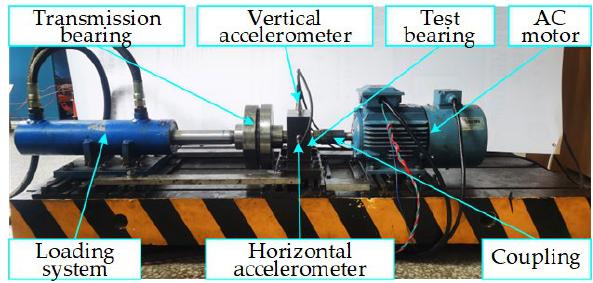
Figure 8. Self-made rolling bearing accelerated degradation testbed.